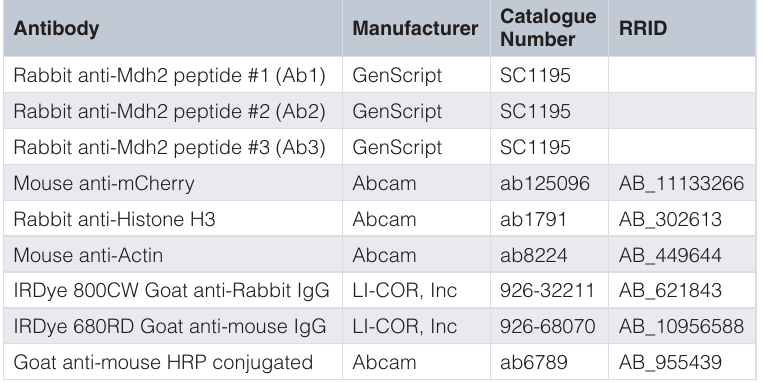
Table 2. Primary and secondary antibodies.